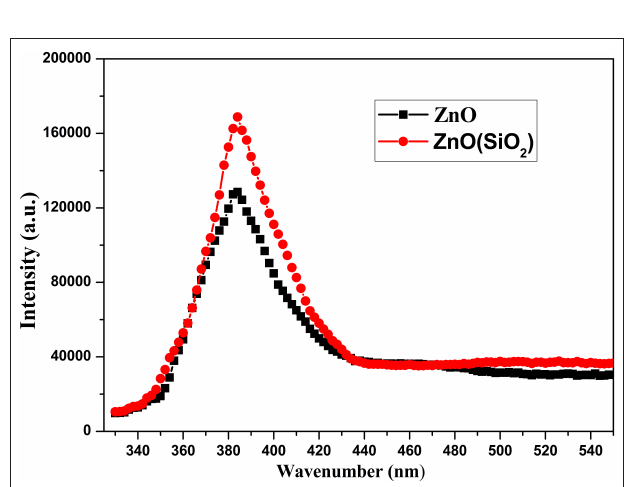
FIGURE 10 | Photoluminescence spectra of bare ZnO and SiO 2 coated on ZnO with deposition of 10min.